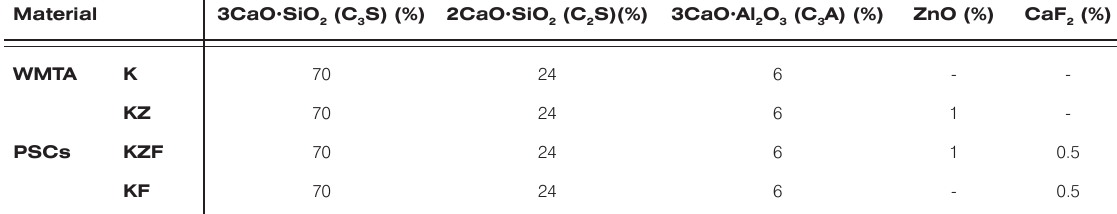
Table 1. Designed mineralogical composition of WMTA and PSCs.